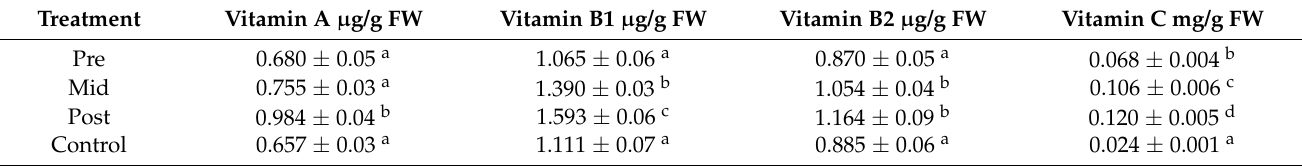
Table 3. Effect of blanching on the content of vitamins in the stem of water dropwort.